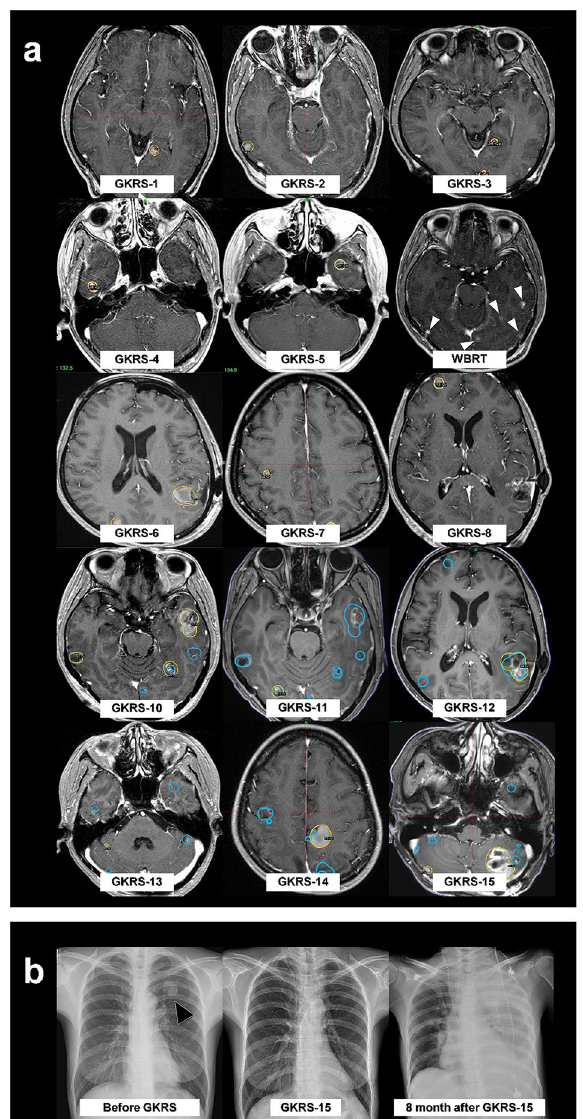
Figure 2. The clinical course of the a 36-year-old woman experiencing 15 GKRS procedures for BM from lung cancer. The patient was diagnosed with synchronous BM with adenocarcinoma of the lung. ( a ) Contrast- enhanced T1-weighted MR images for GKRS treatment. Target volume (red solid line) and prescription isodose volume (PIV) (yellow solid line) have appeared on each treatment planning image. PIVs of previously irradiated BM by gamma knife is marked with blue solid lines. The numerous lesions are indicated with white arrowheads resulting in an additional WBRT after the fifth GKRS. An Ommaya reservoir is inserted into a large cystic BM at the sixth GKRS. The newly developed hemorrhagic BM is shown in the cerebellum of the patient, resulting in metastasectomy and ventriculo-peritoneal shunt surgery after the 14th GKRS. ( b ) The chest X-rays showing lung cancer (black arrowhead) without systemic progression until the 15th GKRS (114 months after the first GKRS). Chest X-ray showing a large amount of pulmonary effusion on the left side after her death, following acute respiratory failure due to septic shock subsequent to 8 months of the last GKRS. *Data from the 9th GKRS session are